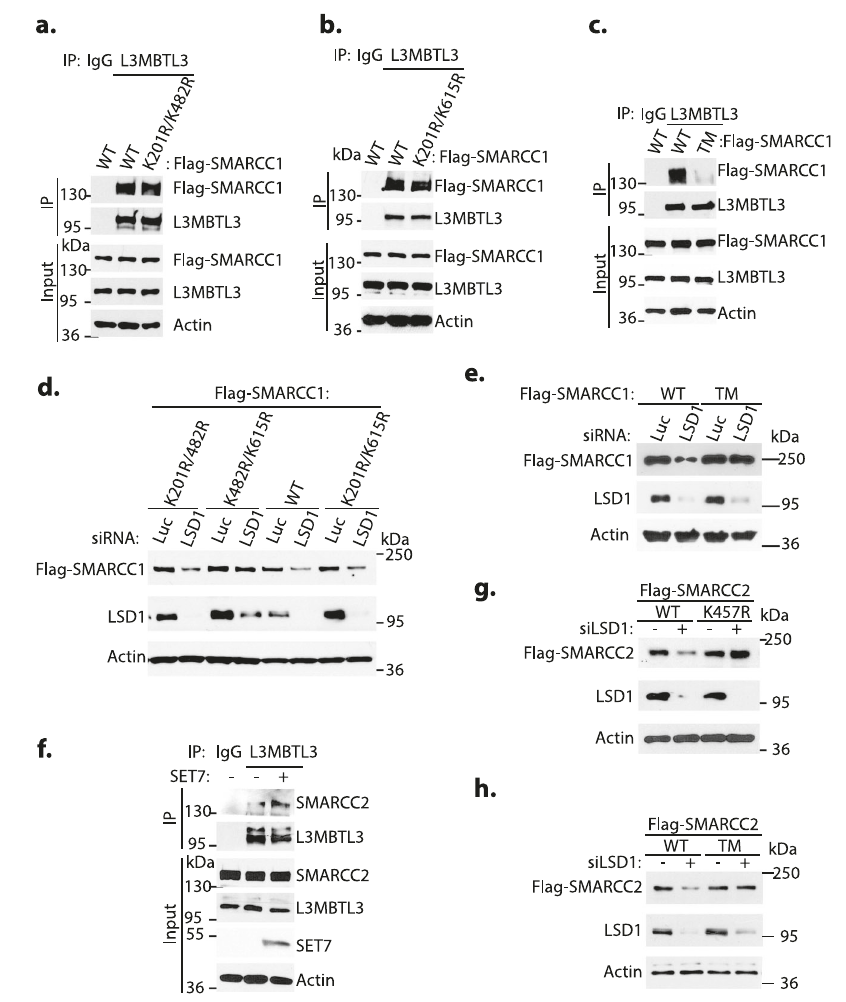
Fig. 4 | L3MBTL3 interacts with the methylated K482 and K615 to regulate SMARCC1. a – c K482 and K615 of SMARCC1 are required for interacting with L3MBTL3. The wildtype (WT), K201R/K482R ( a ) and K201R/K615R ( b ) double mutants, or K201R/K482R/K615R ( c ) triple mutants of Flag-SMARCC1 were transfected into 293T cells for 48h and cell lysates were immunoprecipitated by anti-L3MBTL3 antibodies or IgG (control). The interactions between Flag- SMARCC1 or its mutants and L3MBTL3 were detected by antibodies against indicated proteins. d , e Mutations of K482 and K615 confer resistance to LSD1 silencing. H1299 cells stably expressing the wildtype, K201R/K482R, K482/ K615R, or K201R/K615R double mutants ( d ), or the K201R/K482R/K615R triple mutant of SMARCC1 ( e ) were transfectedwith 50nM siRNAs of luciferase or LSD1 for48handthe levelsofFlag-SMARCC1proteinanditsmutantswereanalyzedby